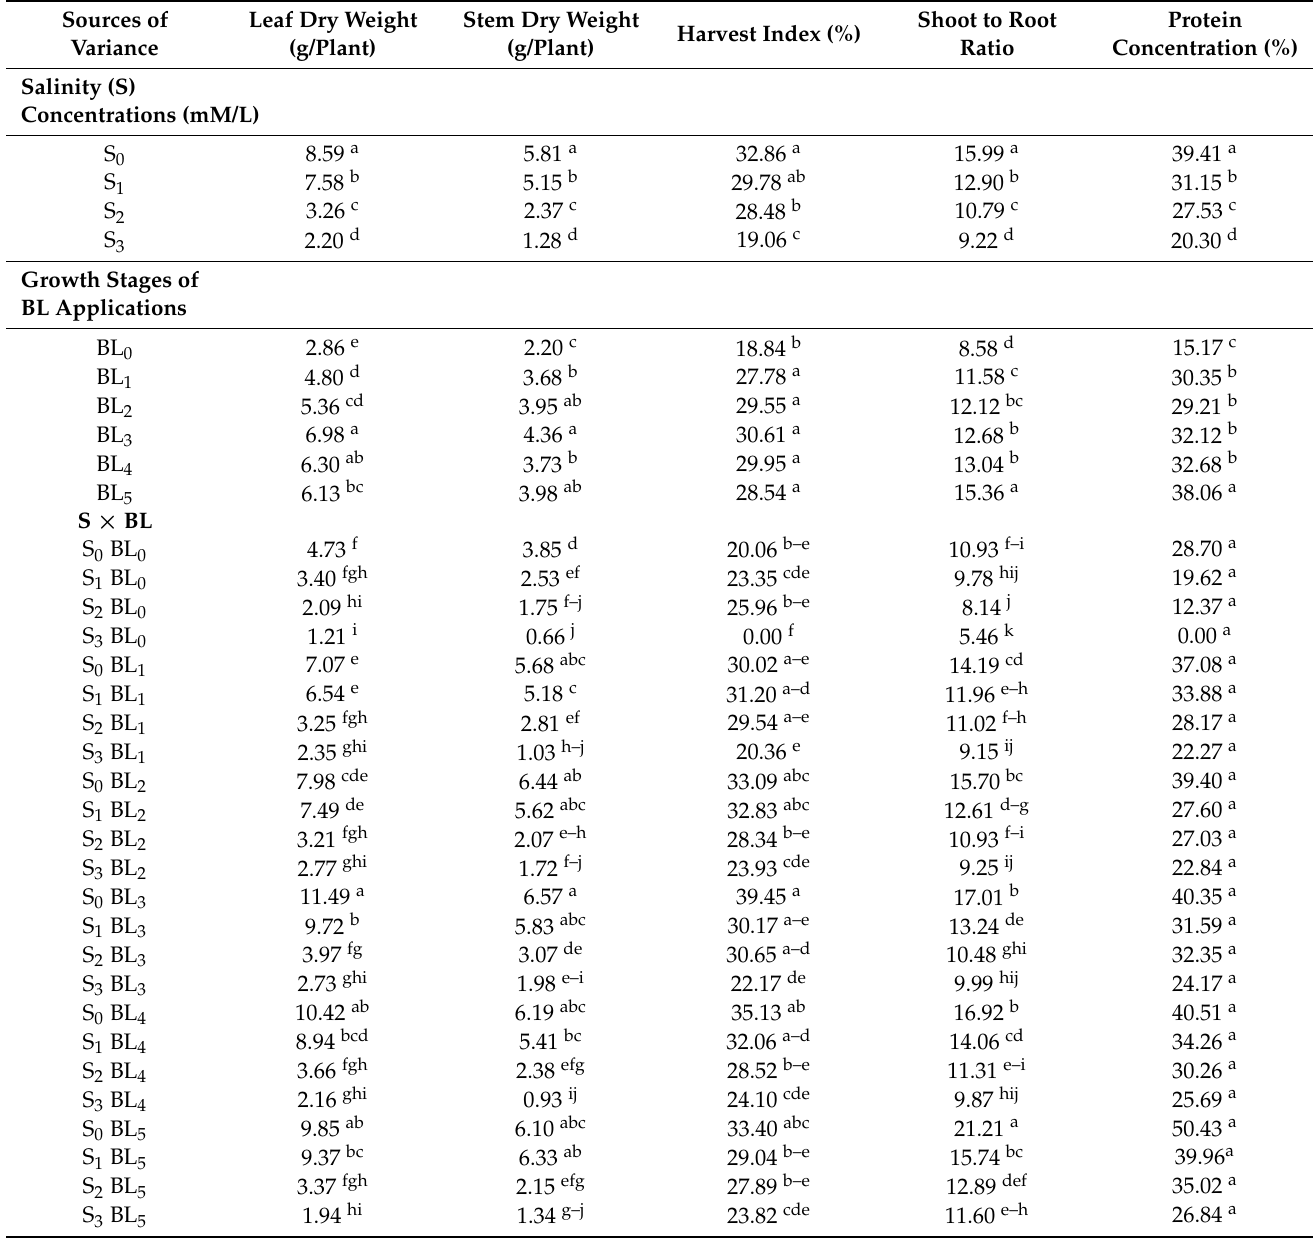
Shoot to Root Protein Harvest Index (%) Ratio Concentration